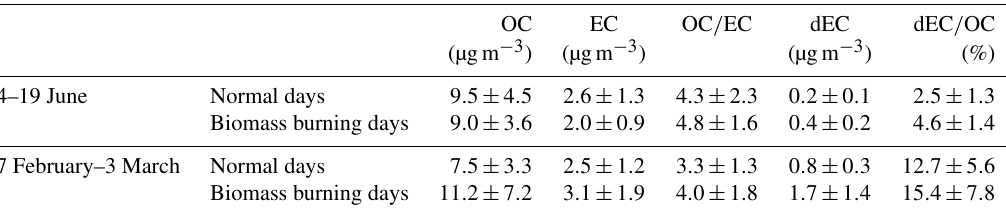
Table 2. Statistics of OC, EC, OC / EC, dEC and dEC / OC during biomass burning days and normal days. The values represent the average ( ± ) standard deviation.